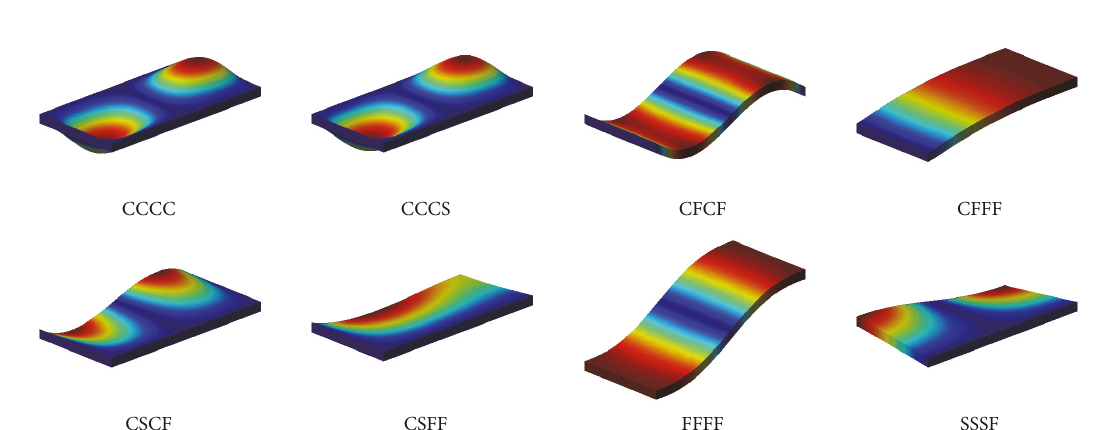
Figure 6: Fundamental mode shape of Al/Al 2 O 3 plates with different boundary